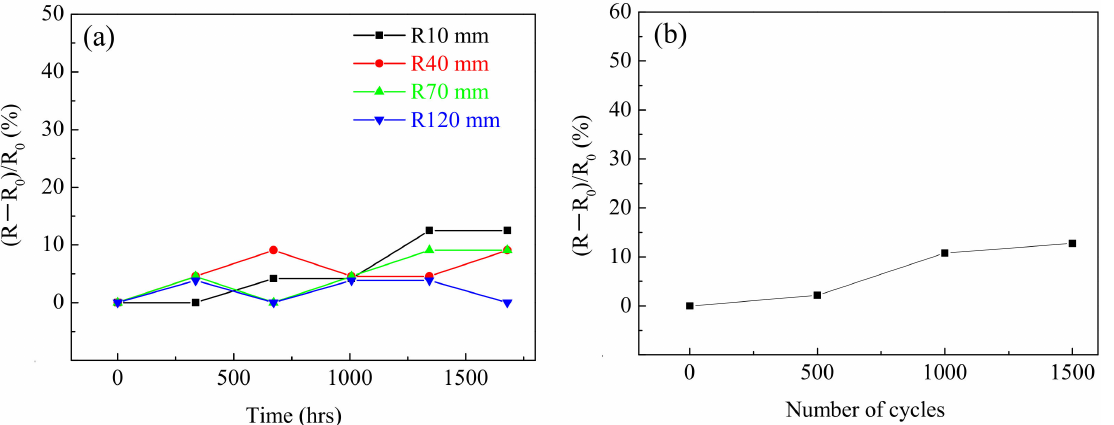
Figure 13. Resistivity change rate of the mechanical reliability test: ( a ) retention testing and ( b ) cycle